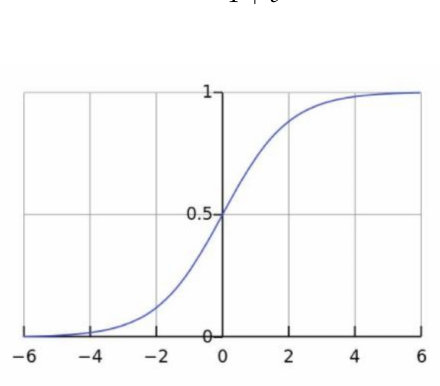
Figure 3. Sigmoid function